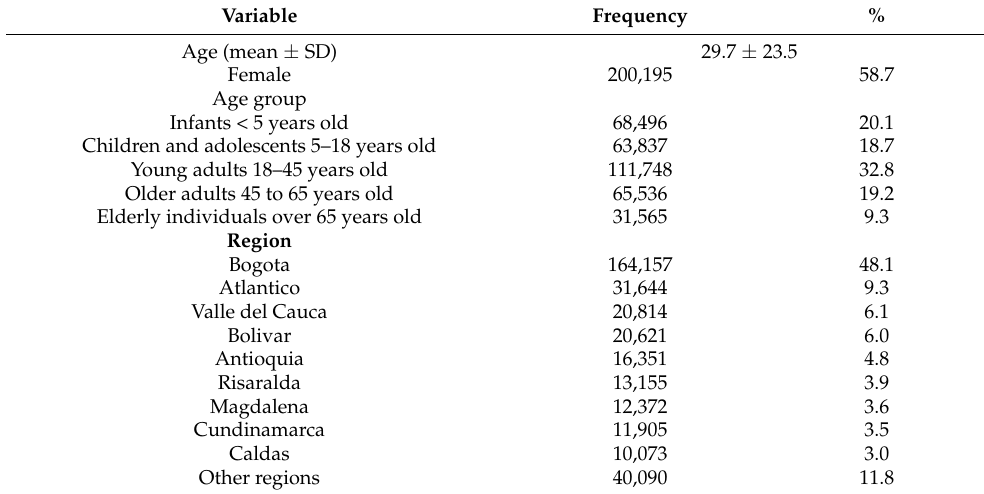
Table 1. Sociodemographic characteristics and regions of origin of patients with viral respiratory tract infections,